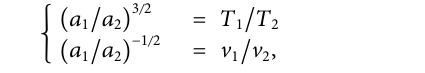
(cid:129) using the semi-major axis — 6 or 5 ratios, in 12-TET and 12-TJI respectively, are untuned, and only 3 are close to consonances, of which 2 are untuned. (cid:129) using the orbital period — 3 ratios are untuned, and only 6 are close to consonances, of which 3 are untuned.